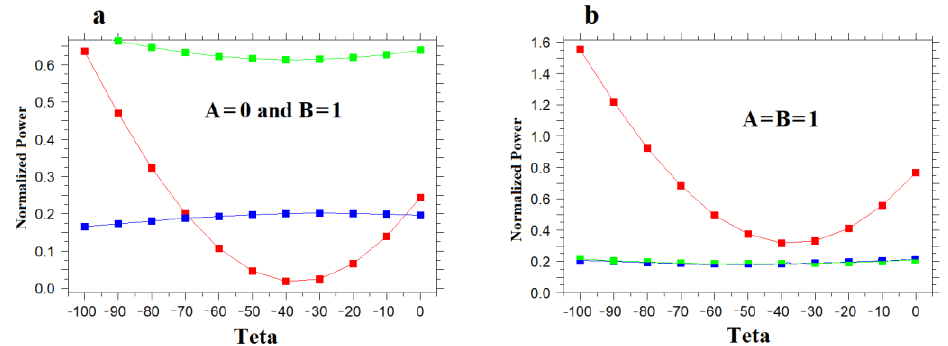
Figure 3. Diagram of output power changes in terms of phase difference changes ( a ) A ≠ B and ( b ) A = B = 1.